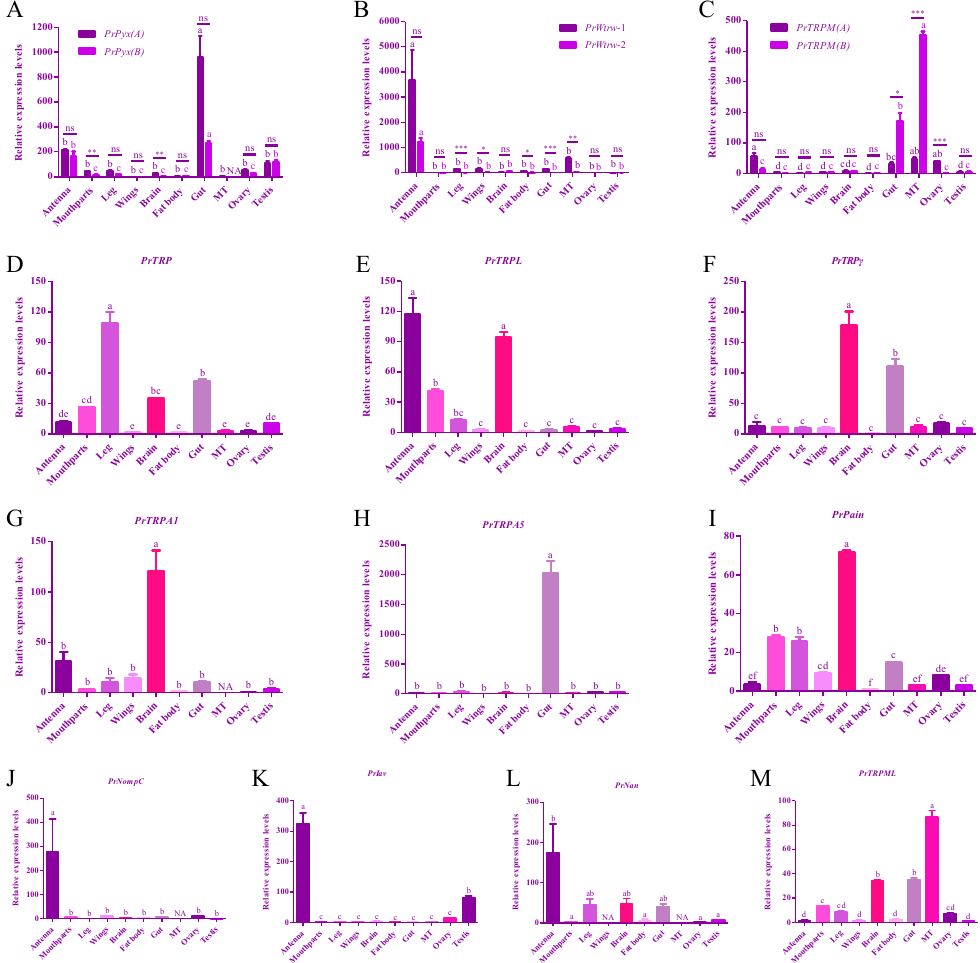
Figure 6. Relative transcriptional levels of two isoforms of PrPyx ( A ), PrWtrw ( B ), PrTRPM ( C ), PrTRP ( D ), PrTRPL ( E ), PrTRP γ ( F ), PrTRPA1 ( G ), PrTRPA5 ( H ), PrPain ( I ), PrNompC ( J ), PrIav ( K ), PrNan ( L ) and PrTRPM L ( M ) in various tissues of 3–5 days old adult P. rapae. “MT” represented malpighian tubules. Asterisks showed the significant di ff erence in expression levels of two isoforms and gene duplications in the same samples. Data represent means ±